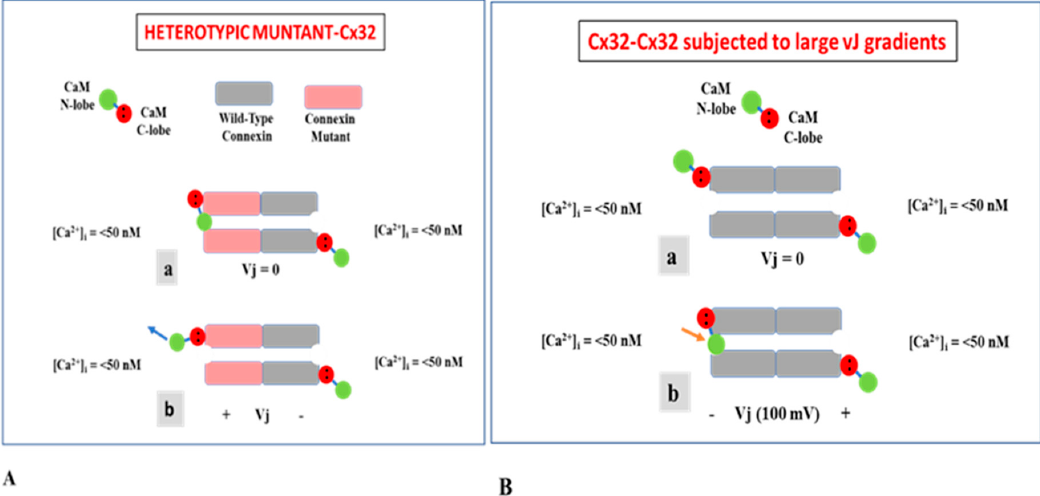
Figure 15. Schematic representation of CaM-Cork gating. CaM is anchored to connexins by its C-lobe at resting [Ca 2+ ] i ( A and B ). Certain connexin mutations enable the negatively charged CaM’s N-lobe to access the channel’s pore and plug it by interacting electrostatically with the positively charged channel’s mouth even at resting [Ca 2+ ] i ( A , a ); the N-lobe can be moved out of the pore with Vj gradients positive at the mutant side ( A , b ). In wild-type connexins (Cx32-CX32), with the application of large Vj gradients the N-lobe can be reversibly forced to plug the channel’s mouth at the negative side of Vj at resting [Ca 2+ ] i ( B , b ).